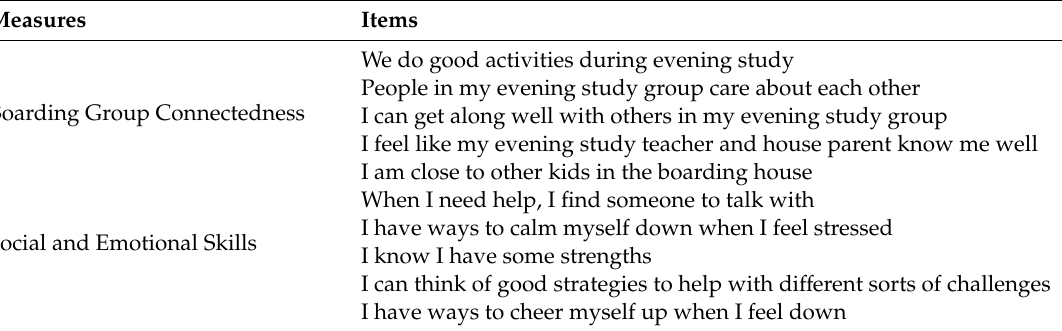
Table 2. Boarding group connectedness and social and emotional skills